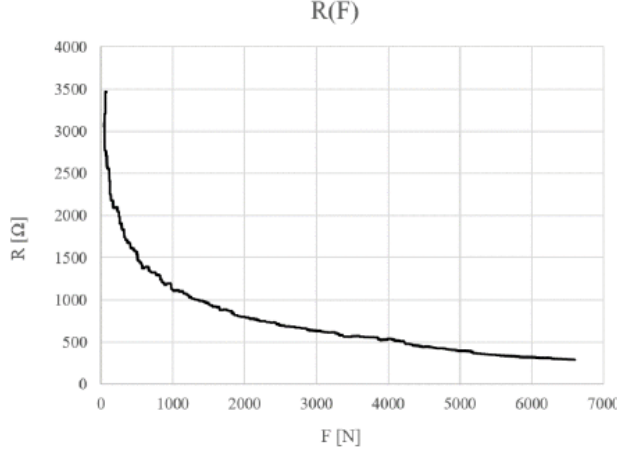
Figure 4. Characteristics of the FSR sensor resistance to pressure (2%wg